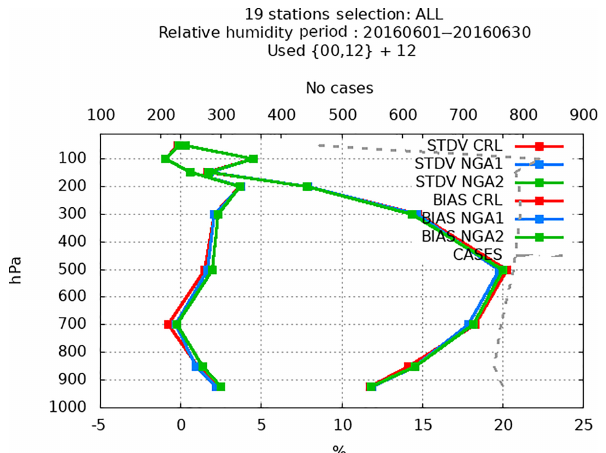
Figure 6. Bias and standard deviation of + 12h relative humid- ity (unit: %) forecasts as a function of vertical level for verifica- tion against radiosonde observations. Scores are for experiments A1 (red), A2 (blue) and A3